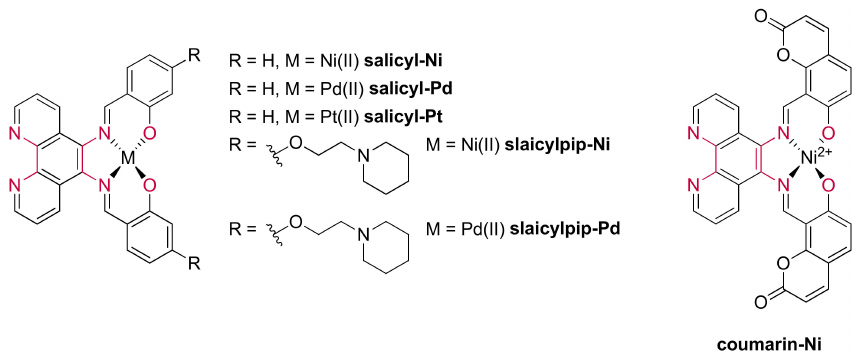
Figure 30. Structure of the Schiff base bridging ligands used to form the bimetallic compounds studied in the presence of